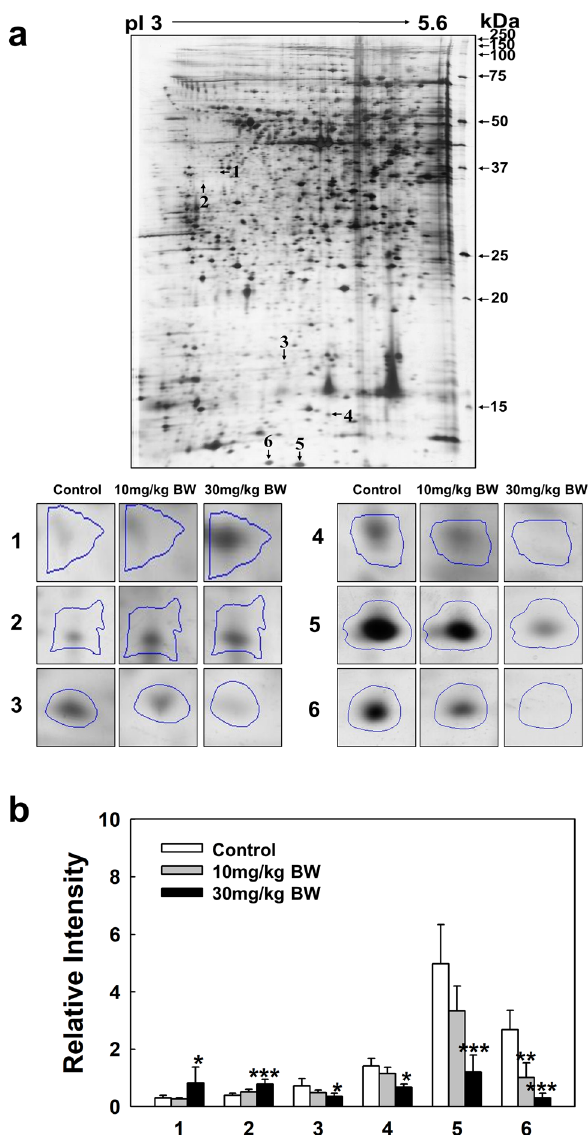
Figure 3. 2-DE analysis of kidney tissue proteins obtained using 3–5.6 pI range strips. ( a ) Gel pattern of tissue proteins obtained using 3–5.6 pI strips. Protein spot images were analyzed using the Progenesis Samespot software program (Nonlinear Dynamics, Newcastle upon Tyne, UK). ( b ) Spot volumes were normalized by comparison to the total spot volume. The quantity of each spot is presented as the relative intensity. The images represent the mean ± SD of five separate experiments. *, **, and *** indicate p -values of 0.05, 0.01, and 0.001, respectively compared to the